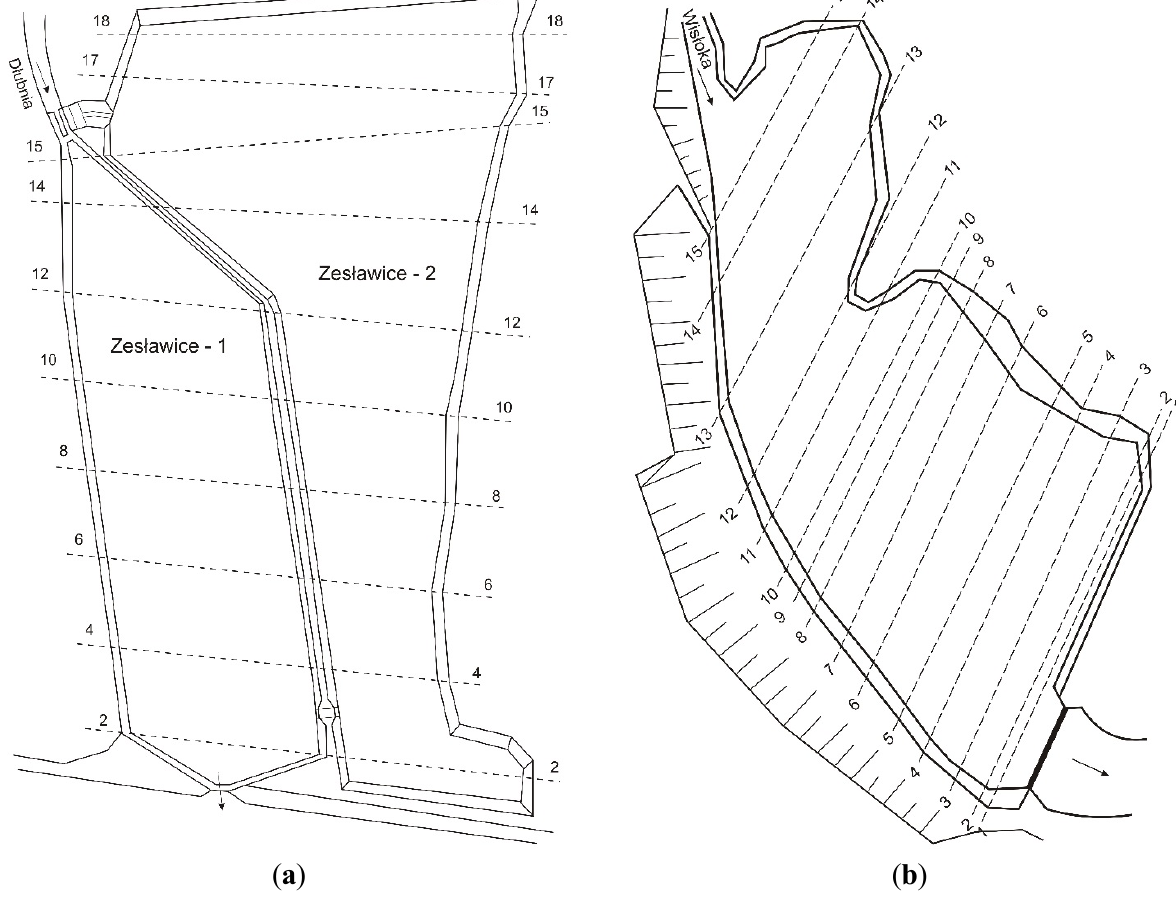
Figure 2. Reservoirs: ( a ) in Zes ł awice and ( b ) in Krempna. Cross-sections are marked in